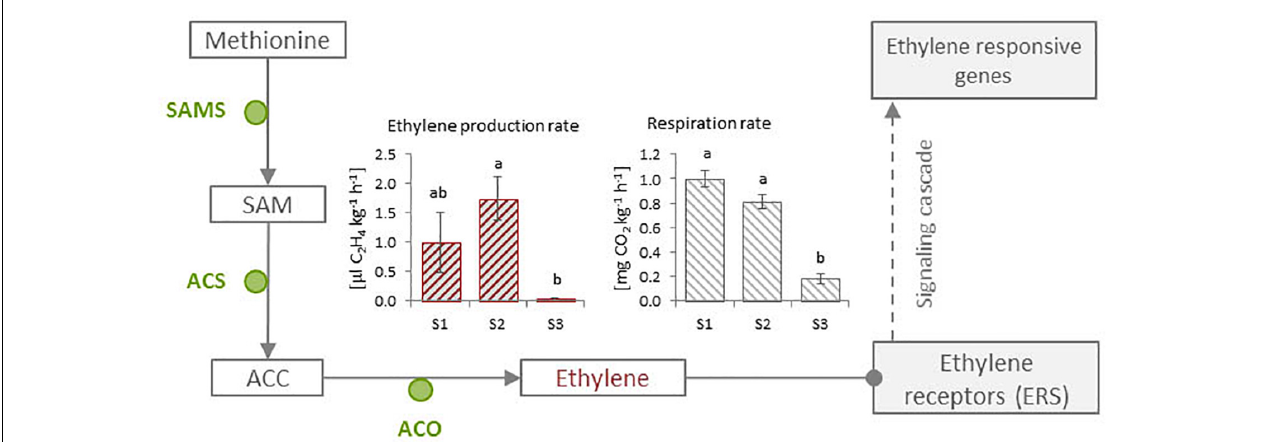
FIGURE 4 | Ethylene production and respiration in Cistus fruits of three developmental stages (S1–S3). Bars with different letters are significantly different ( p < 0.05) according to ANOVA post hoc Tukey’s test. Ethylene is synthesized from methionine (A) in a simple three-step biosynthetic pathway involving the enzymes S -adenosyl methionine synthetase (SAMS), 1-amino cyclopropane-1-carboxylate synthase (ACCS), and 1-amino cyclopropane-1-carboxylate oxidase (ACO). S -adenosyl methionine, synthesized from methionine in a reaction catalyzed by SAMS, is converted by ACCS into ACC, and then ACC is oxidized by ACO to form ethylene. Ethylene further induces a signaling cascade which activates ethylene-responsive genes.